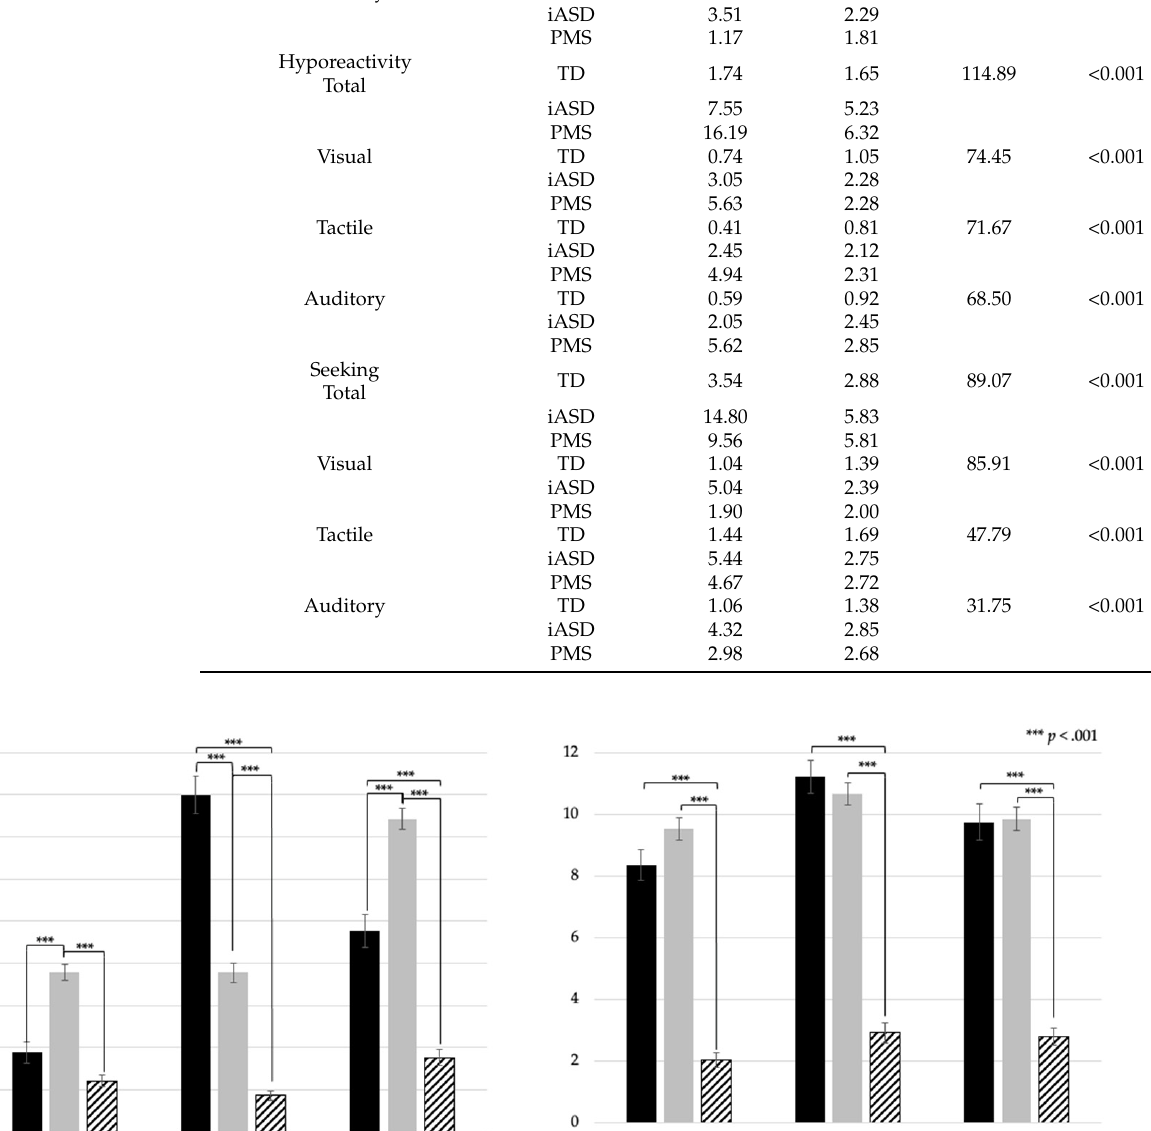
Figure 1. SAND domain (Hyperreactivity, Hyporeactivity, Seeking) and modality (Visual, Tactile, Auditory) mean scores for PMS, iASD, and TD